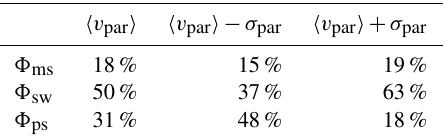
Table 3. Estimated fate of oxygen ions expressed as percentages of outflow flux. (cid:56) represents the flux, and subscripts ms, sw and ps represent magnetosheath, solar wind and plasma sheet, assuming that the plasma sheet is limited by the distant X-line at X GSE = − 100 R E